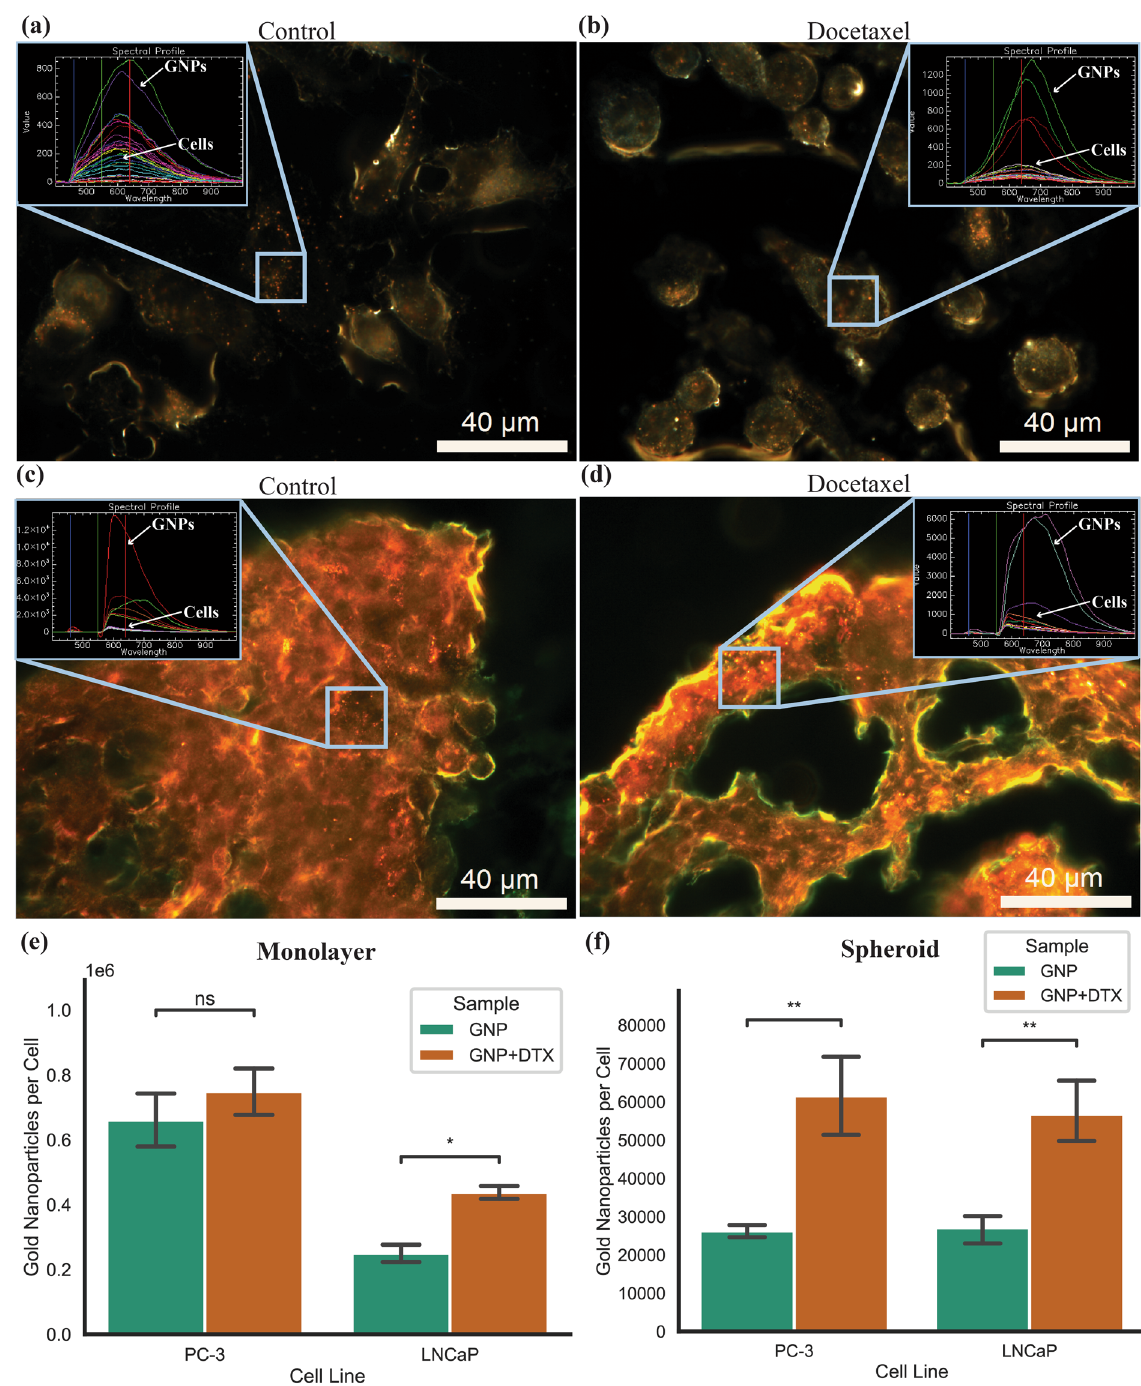
Figure 4. Gold nanoparticle uptake in two-dimensional and three-dimensional models ( a , b ) Darkfield images of ( a ) a control and ( b ) a docetaxel-treated monolayer of PC-3 cells. ( c , d ) 10 µm spheroid sections of ( c ) control and ( d ) docetaxel-treated PC-3 cells treated with docetaxel and gold nanoparticles. Inset is hyper spectral spectrum of gold nanoparticles and cells. Scale bar is 40 µm. ( e , f ) Uptake of gold nanoparticles in ( e ) monolayer and ( f ) spheroids of PC-3 and LNCaP with and without docetaxel. Error bars are the 95% confidence interval from three independent experiments. ns indicates no significance, * indicates 0.01 < P < 0.05, ** indicates 0.001 < P <